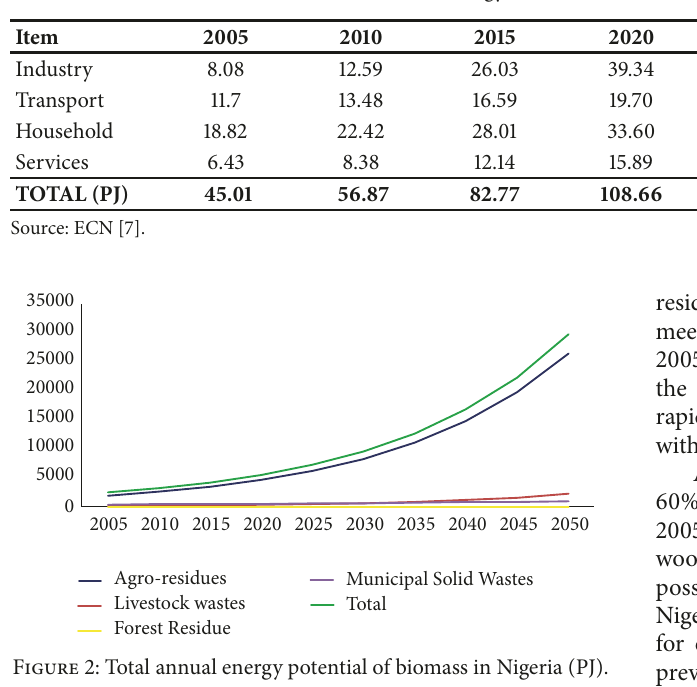
Table 8: Total energy demand based on 10% GDP growth rate (MTOE).